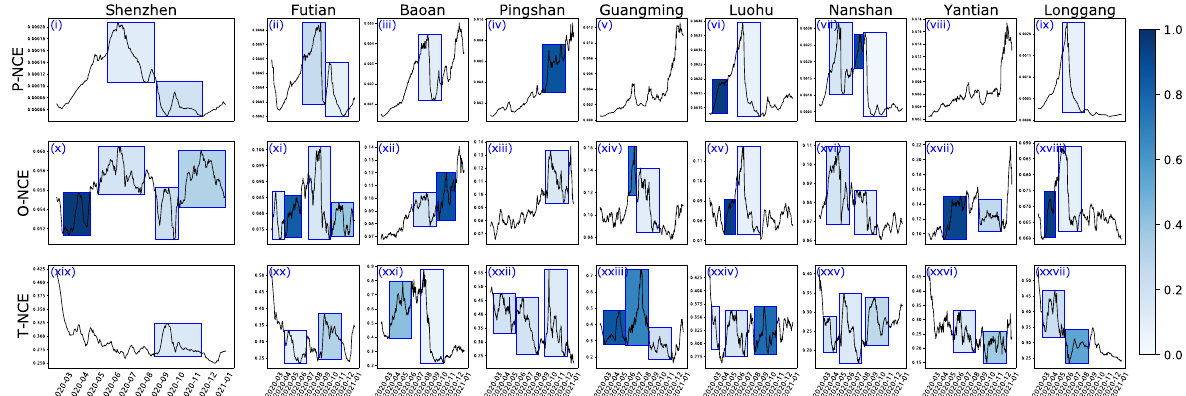
Fig. 5 Self-organised volunteer behaviour during the COVID-19 outbreak in Shenzhen. Maximal self-organisation intervals (boxed regions) for three types of NCE in Shenzhen and Shenzhen districts. (max duration = 90, min duration = 5.). (i – ix): NCE of task participation (P-NCE) in Shenzhen and Shenzhen districts. (x – xviii): NCE of organiser preference (O-NCE) in Shenzhen and its districts. (xix – xxvii): NCE of task preference (T-NCE) for Shenzhen and its districts.